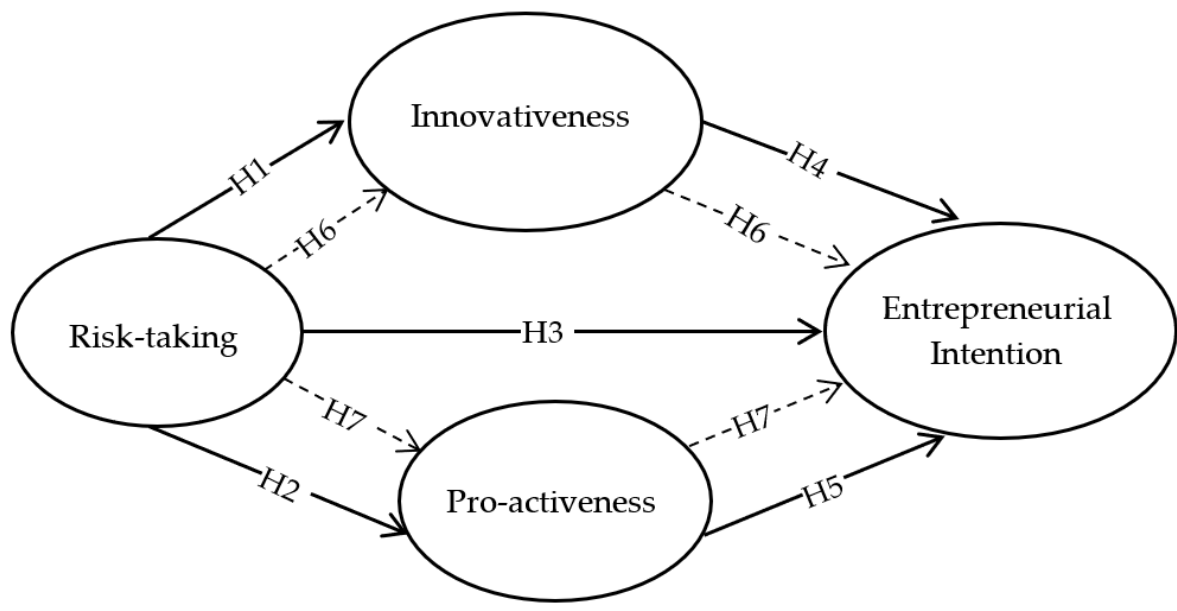
Figure 1. The theoretical model (straight line refers to direct effect; dotted line refers to indirect